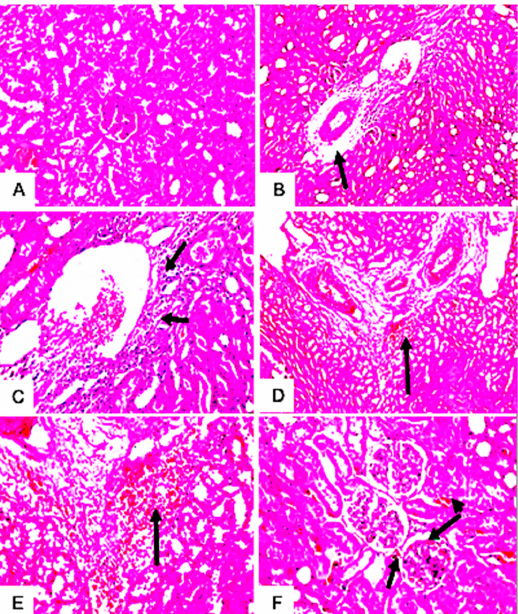
Figure 8. Histopathological changes in the kidney tissues of male albino rats treated with the combined Alternaria mycotoxins (ALT, AOH, TeA, and AS); no histopathological alteration in the glomeruli and tubules at the cortex were recorded in untreated and treated rats (control) ( A ); perivas- cular edema and inflammatory cell infiltration were detected surrounding the dilated blood vessels at the cortex (black arrow) ( B , C ); focal hemorrhage of extravagated red blood cells were observed in between the tubules (black arrow) ( D , E ); a congestion in the glomerular tufts and intertubular blood vessels (black arrow) was also detected ( F ).